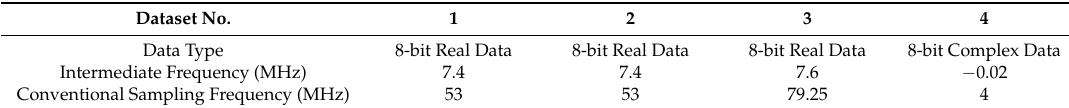
Table 1. The main parameters of GNSS signals used in the experiments. Dataset